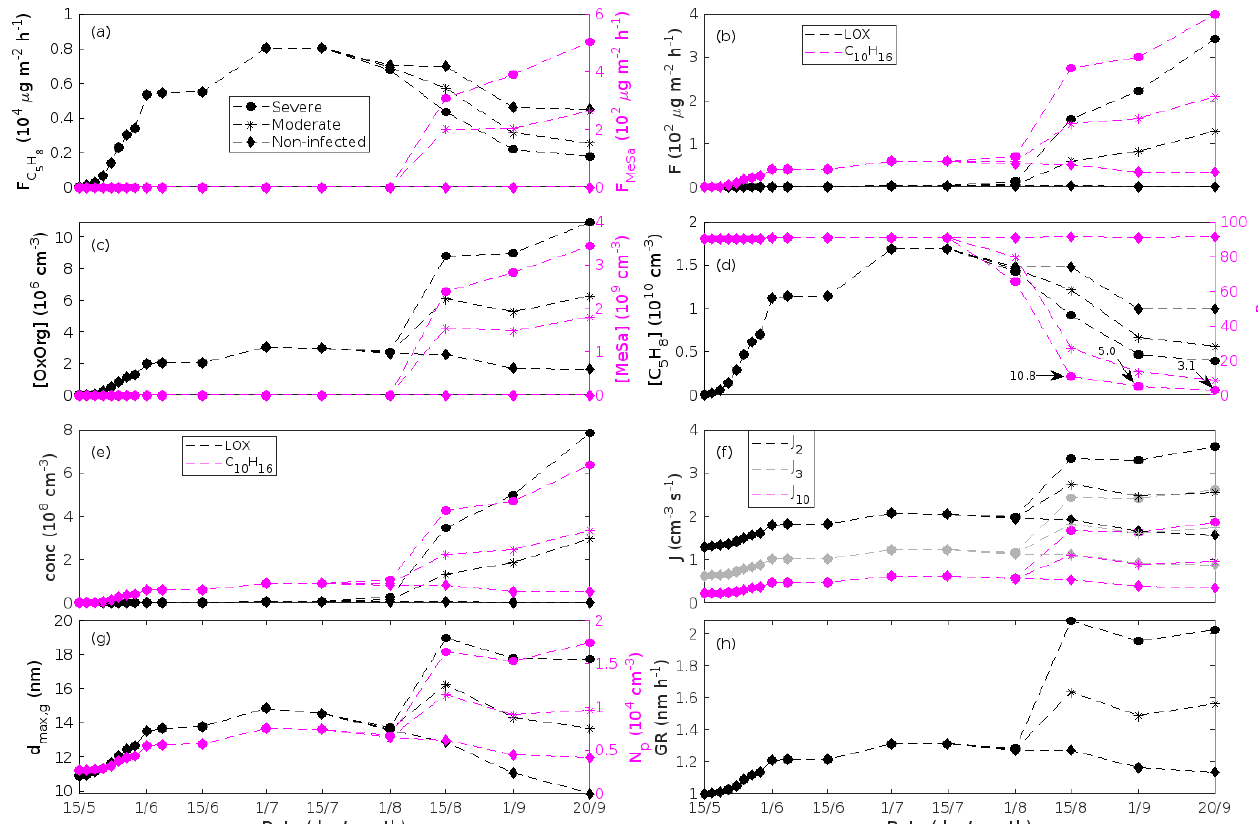
Figure 7. A pure oak stand infected by oak powdery mildew in comparison to a non-infected pure oak stand. Canopy emissions of ( a , left axis) isoprene, ( a , right axis) methyl salicylate, and (b) lipoxygenase pathway volatiles and monoterpenes. Atmospheric concentrations of ( c , left axis) OxOrg, ( c , right axis) methyl salicylate, ( d , left axis) isoprene, and (e) lipoxygenase pathway volatiles and monoterpenes. ( d , right axis) The ratios of isoprene-to-monoterpene carbon concentrations. (f) Formation rates of 2, 3, and 10nm particles. ( g , left axis) Daily maxima diameter of the growing particle mode and ( g , right axis) number concentrations of formed particles. (h) Growth rates of newly formed particles. “Moderately” and “severely” refer to 30% and 80%, respectively, of the leaf area that has been infected by fungi by the onset of